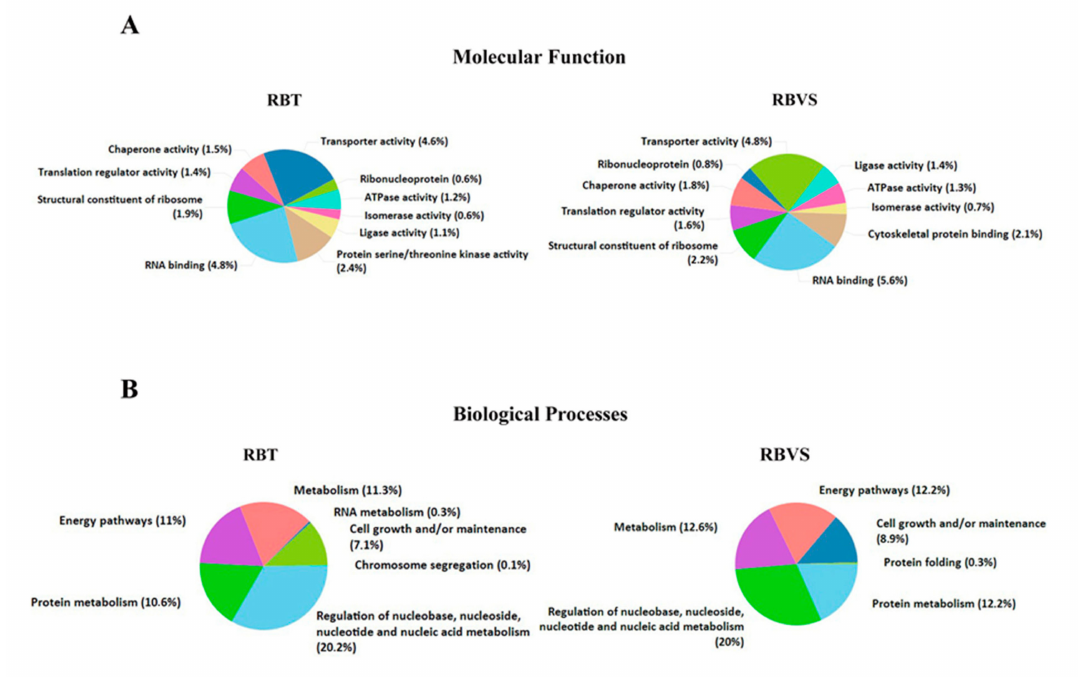
Figure 3. Gene enrichment of RBT- and RBVS-exosomal proteins. ( A ) Graphical representation of the molecular function and ( B ) Biological processes gene enrichment obtained by FunRich software for the 5217 and 3637 proteins, found in RBT- and RBVS-derived exosomes,